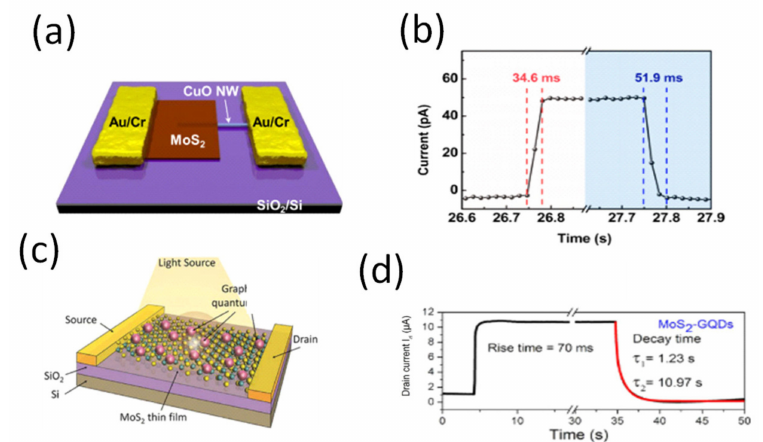
Figure 11. ( a , b ) Schematic representation of a MoS 2 / CuO nano-sheet on 1D hetero-junction photodiode, photo-responsive rise and decay times of a MoS 2 / CuO hetero-junction photodiode under light illumination of λ = 570 nm at P light = 1.4 mW and a bias voltage of − 2 V. Reproduced with permission from reference [138], Copyright 2016, American Chemical Society ( c , d ) Schematic of a MoS 2 -GQDs hetero-structure phototransistor, Time-dependent photoresponse of MoS 2 -GQDs device. Reproduced with permission from reference